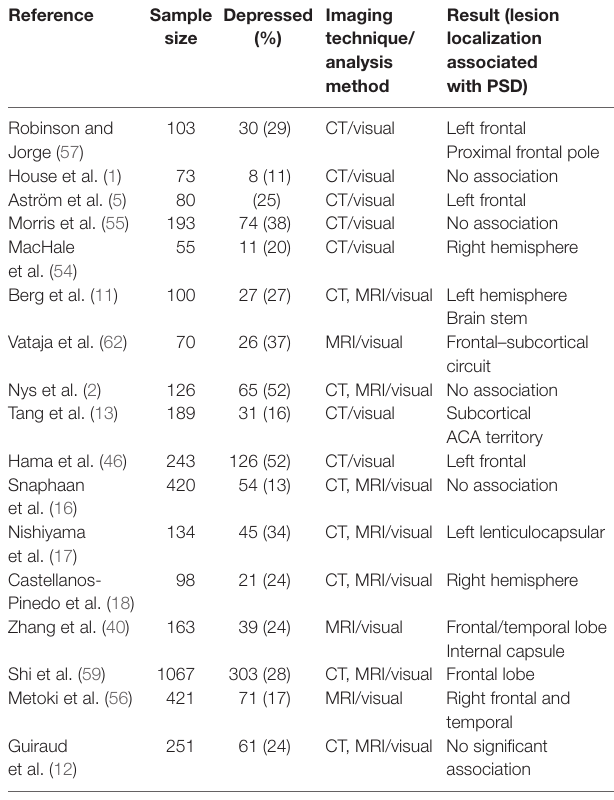
TAbLe 3 | Studies using visual judgment for the analysis of lesion location and PSD.